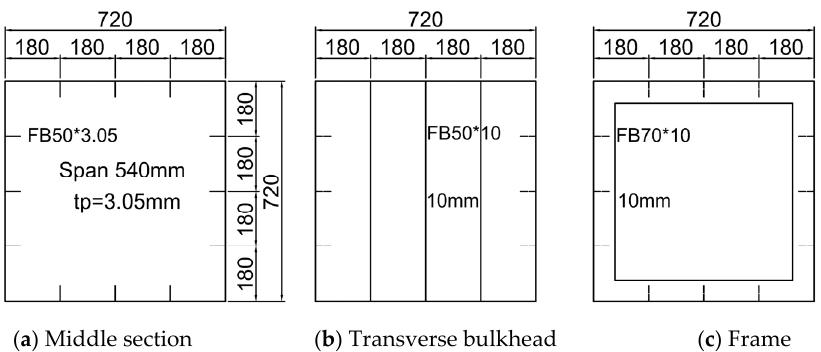
Figure 1. Cross-section of box girder MST-3 in the experiment [23]. (Span length = 540 mm; Plating thickness tp = 3.05 mm; Stiffener FB50 × 3.05; Stiffener spacing = 180 mm).